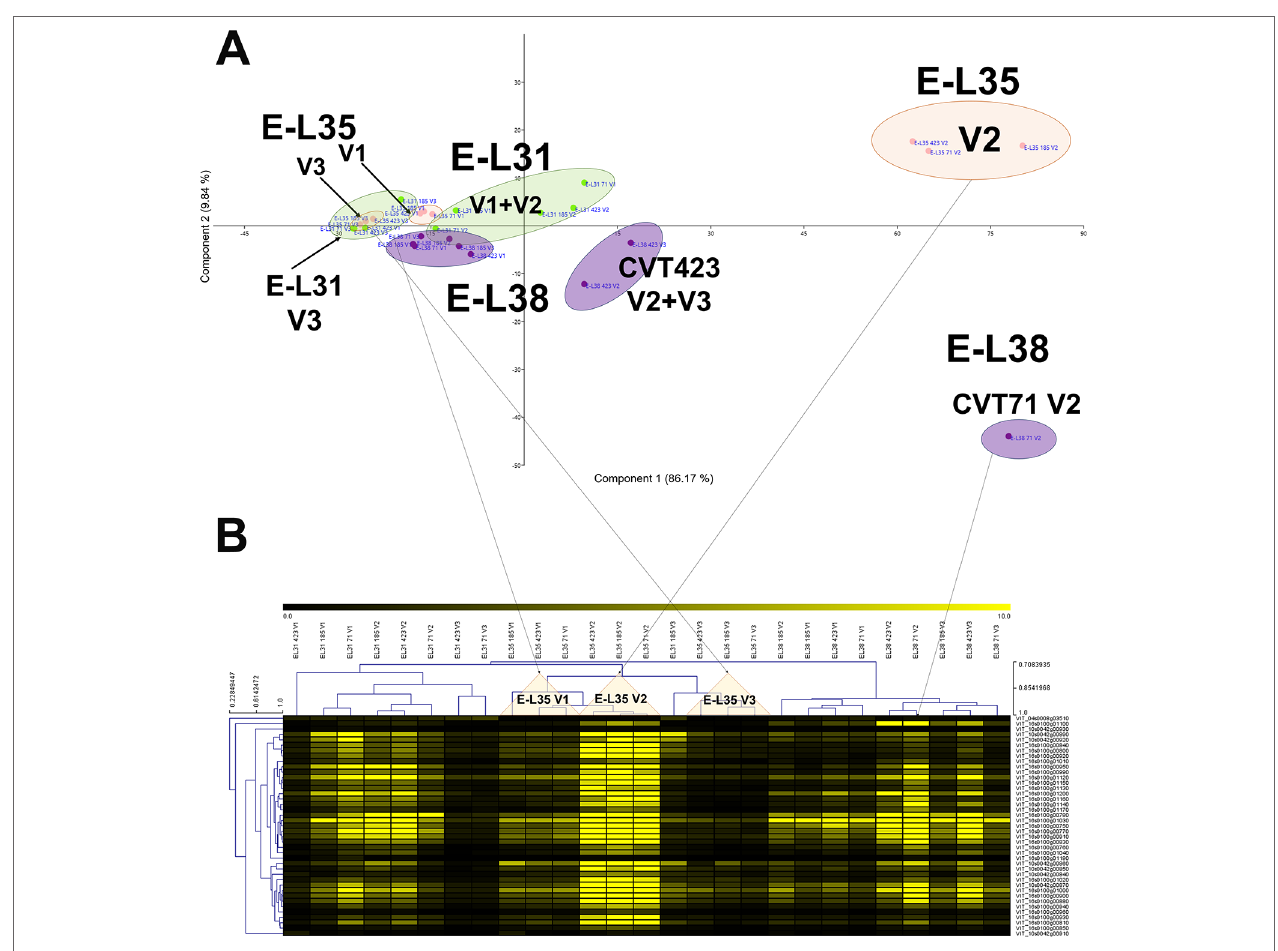
FIGURE 4 | Environmental effect on stilbenoid metabolism. (A) PCA and (B) MeV heat map of transcripts belonging to the stilbene synthase ( STS ) gene category. Color scale of the heat map chart ranges from black (low expression) to yellow (high expression, FPKM > 10).